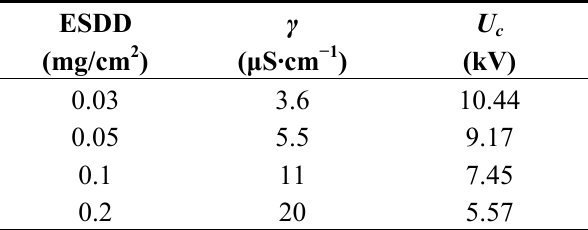
Table 1. Initial experimental